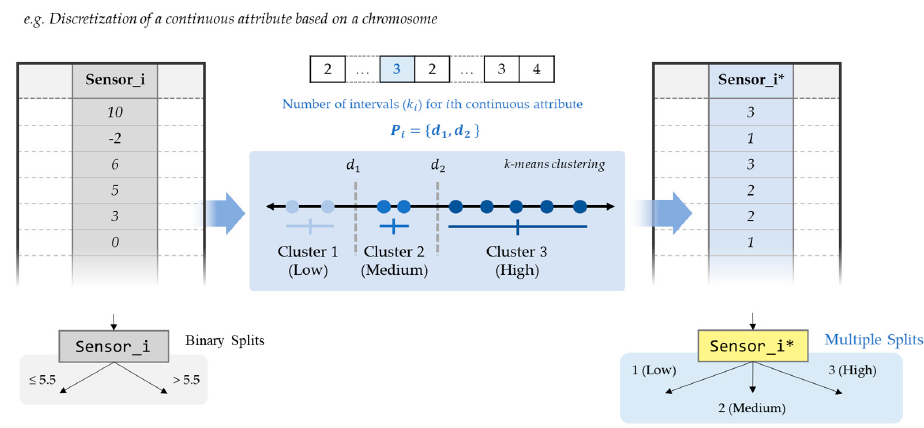
Figure 5. Evaluation of a chromosome with k -means clustering for discretization.